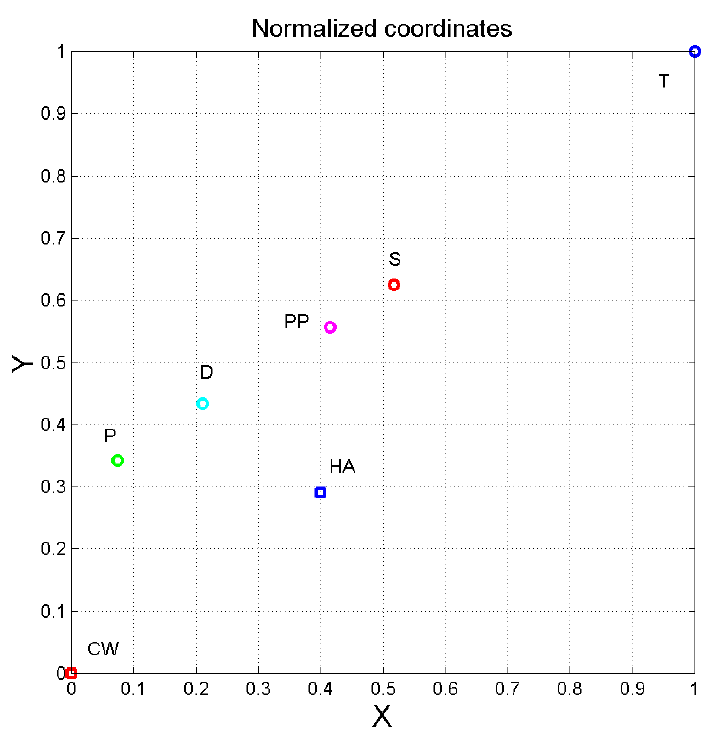
Figure 7. Coordinates 𝑥 and 𝑦 of the resulting vector (5) of a literary work, referred (normalized) to the coordinates of speeches at the Temple and at Clear Water, by assuming Clear Water as the origin, coordinates (0, 0), CW, and the speeches at the Temple located at (1, 1), T. P: Parables ; D: Disciples ; PP: People ; S: Synagogues . T: Temple ; CW: Clear Water ; HA: Horns of Hattin .